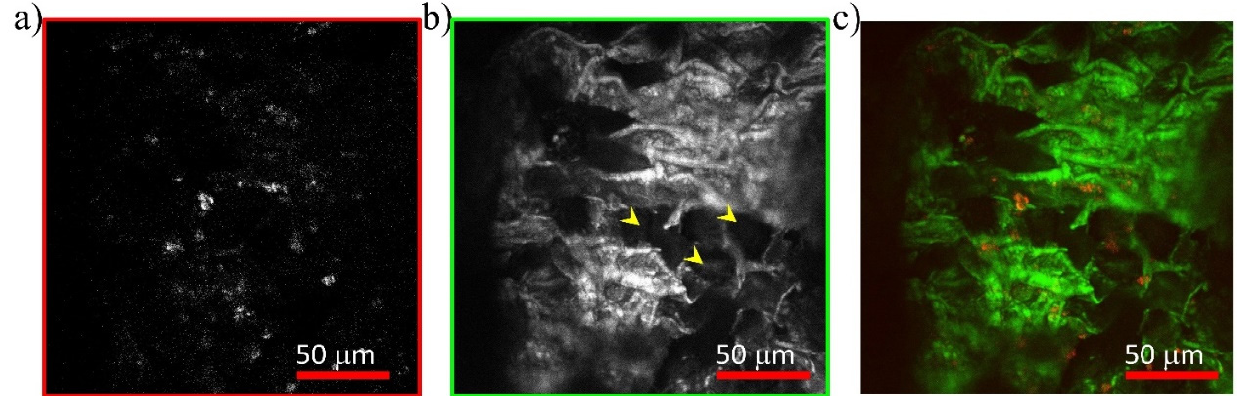
Figure 5. ( a ) SHG, ( b ) TPEF, and ( c ) merged TPEF/SHG images of chestnut acquired using an excitation wavelength of 800 nm, a FOV of 200 × 200 µ m 2 , and a resolution of 1024 × 1024 pixels. Tyloses (pointed out by the yellow arrowheads) are visible inside the parenchyma rays.